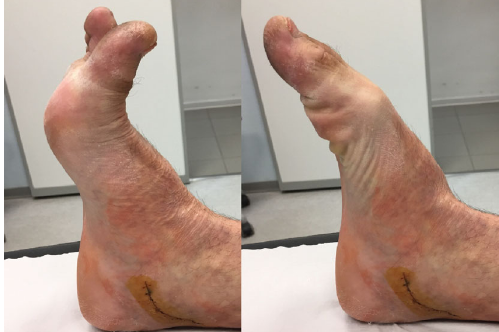
Figure 5: Restoration of active fl exion/extension of the great and lesser